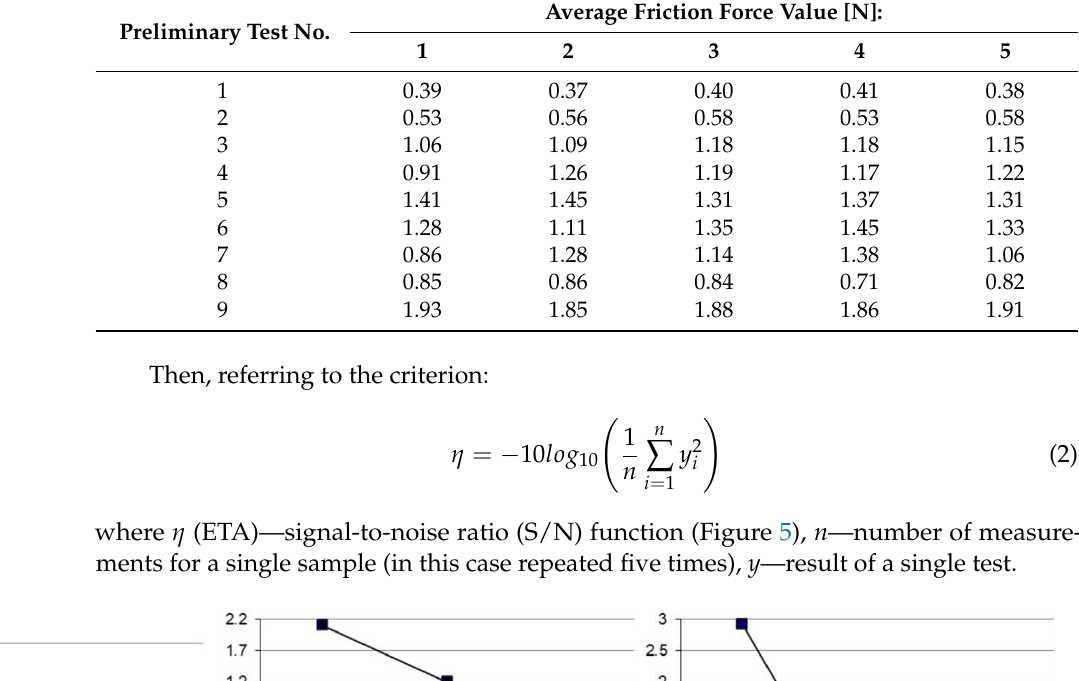
Table 3. Preliminary tests results.